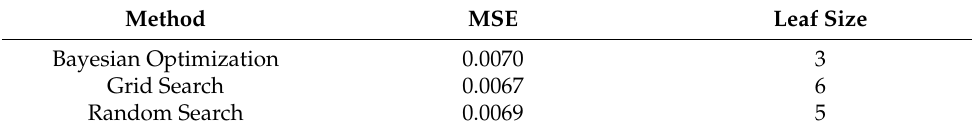
Table 3. Hyperparameter tuning results (Decision Tree).